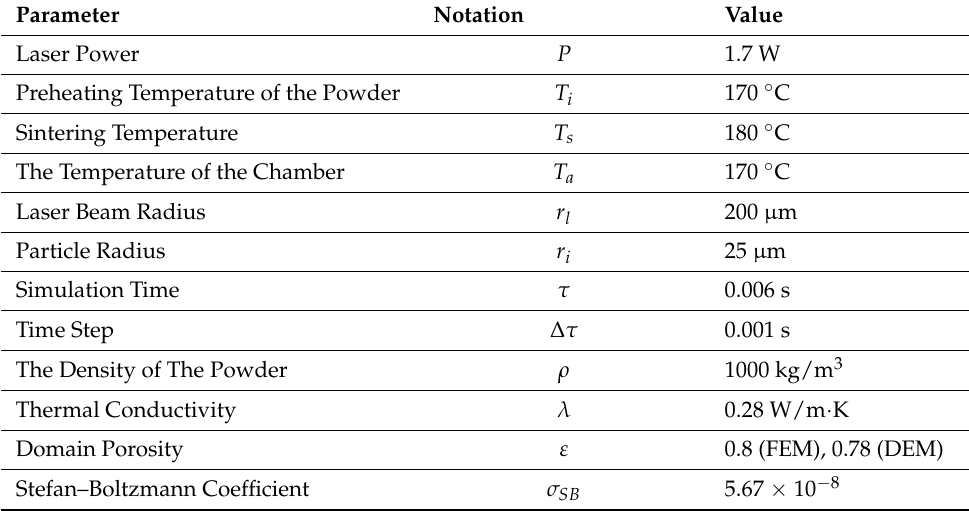
Table 1. The values of parameters used in the DEM